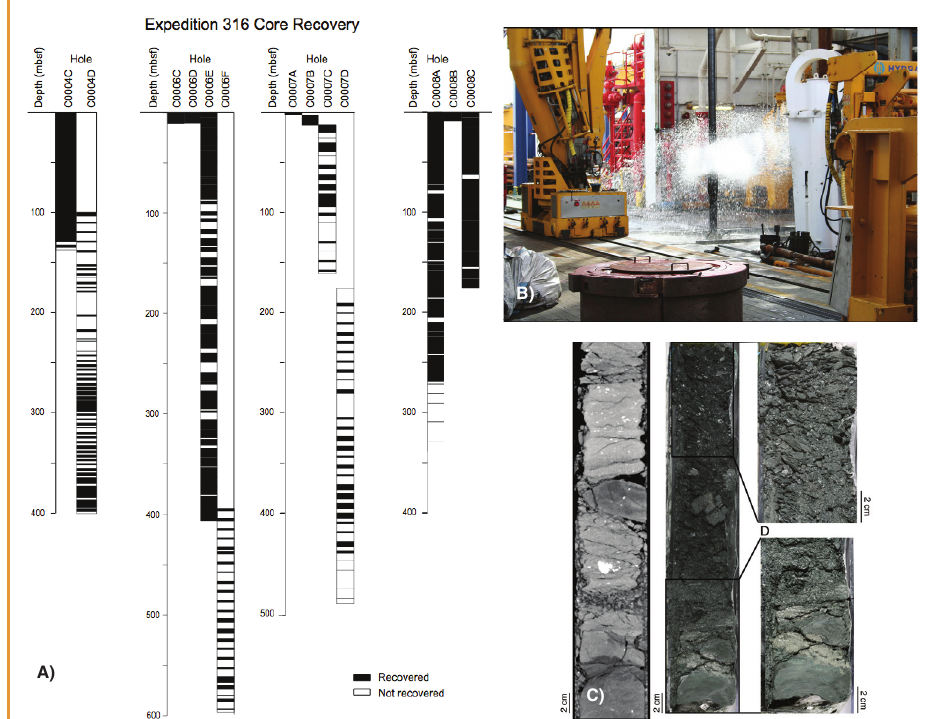
Figure 5. Coring results, coring operations and laboratory work during Expedition 316. [A] Core recovery during Exp. 316. [B] Drill pipe being disconnected immediately prior to removing a core. [C] Composite showing CT image, split core surface, and detail photos of fault zone